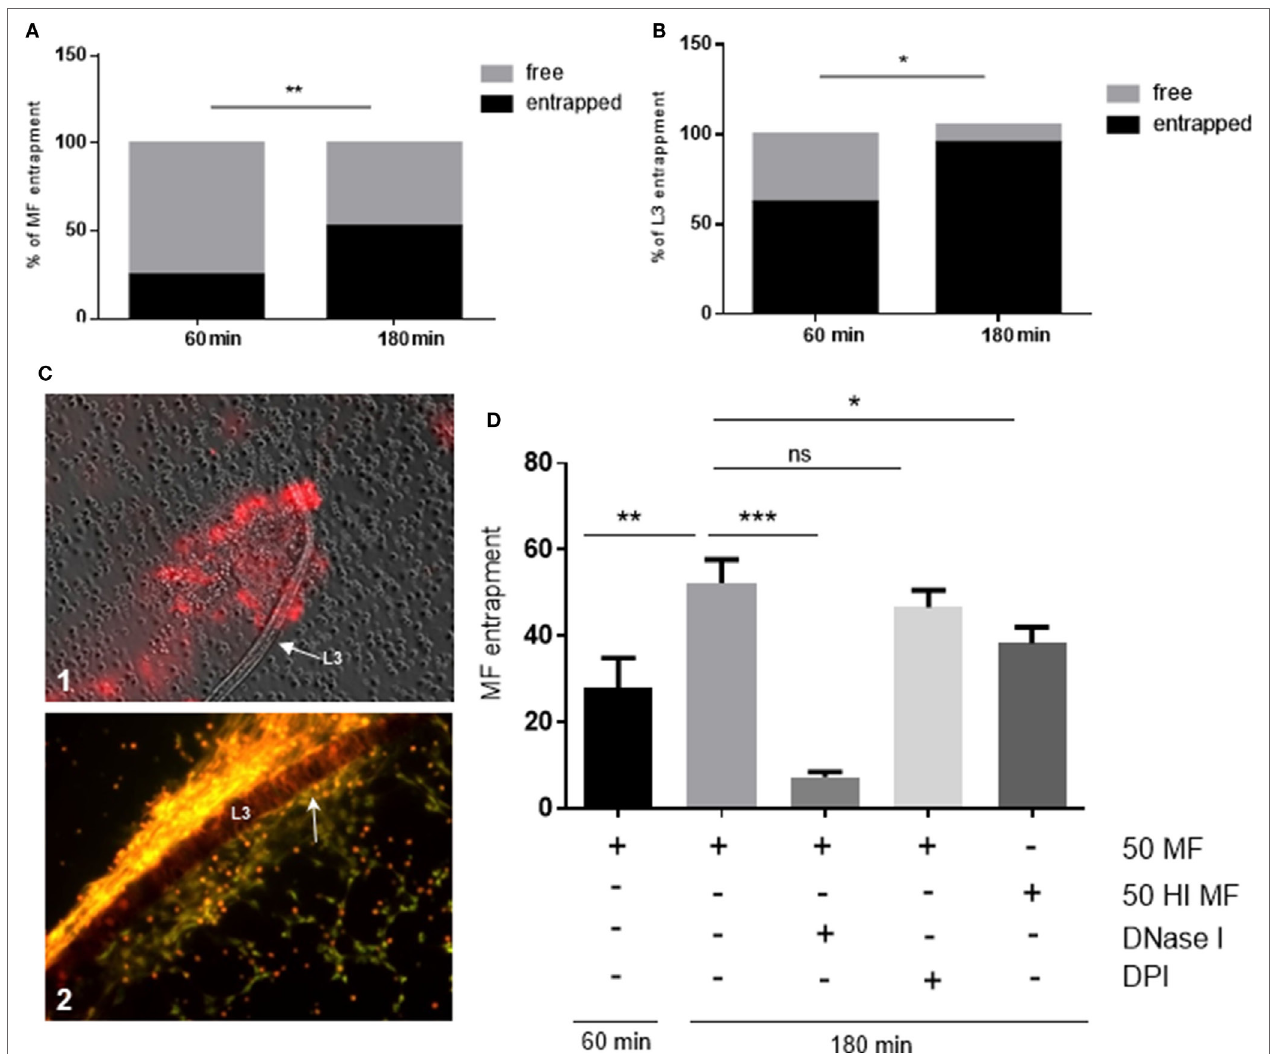
FigUre 6 | Dirofilaria immitis- induced parasite entrapment. Canine polymorphonuclear neutrophils (PMN) were exposed to vital D. immitis microfilariae (a) or L3 (B,c) for 60 and 180 min. (D) In parallel settings, the same number of PMN was incubated either with heat-inactivated (HI) microfilariae (HI MF) or pretreated with diphenyleneiodonium (DPI) before exposure to vital microfilariae. Furthermore, DNase I was added at the moment of exposure to vital microfilariae. Larvae were considered as entrapped when PMN and/or PMN-derived neutrophil extracellular traps (NETs) were in contact with larvae. The data are expressed as percentage of entrapped larvae relative to the total amount of larvae per condition. The formation of “clasp”-like NET structures sticking mainly to the anterior part of the larvae is displayed in white arrow: image [ (c) ,